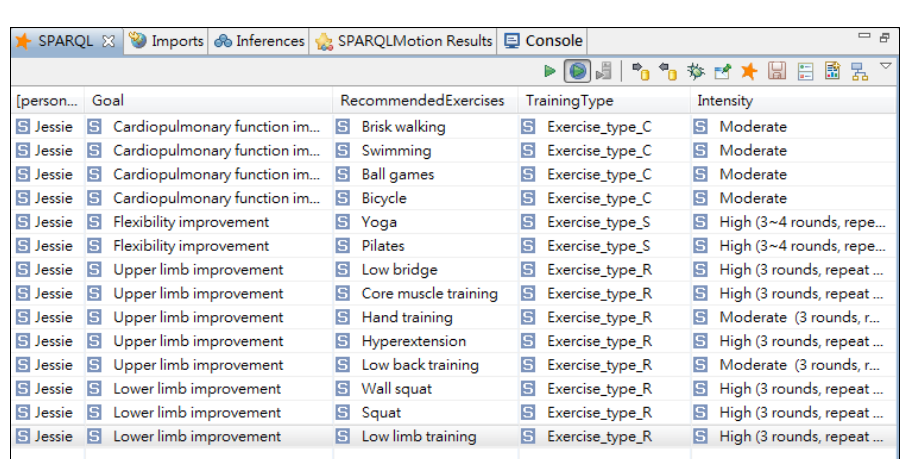
Figure 12. An example of SPARQL query result, Jessie‘s exercise plan.